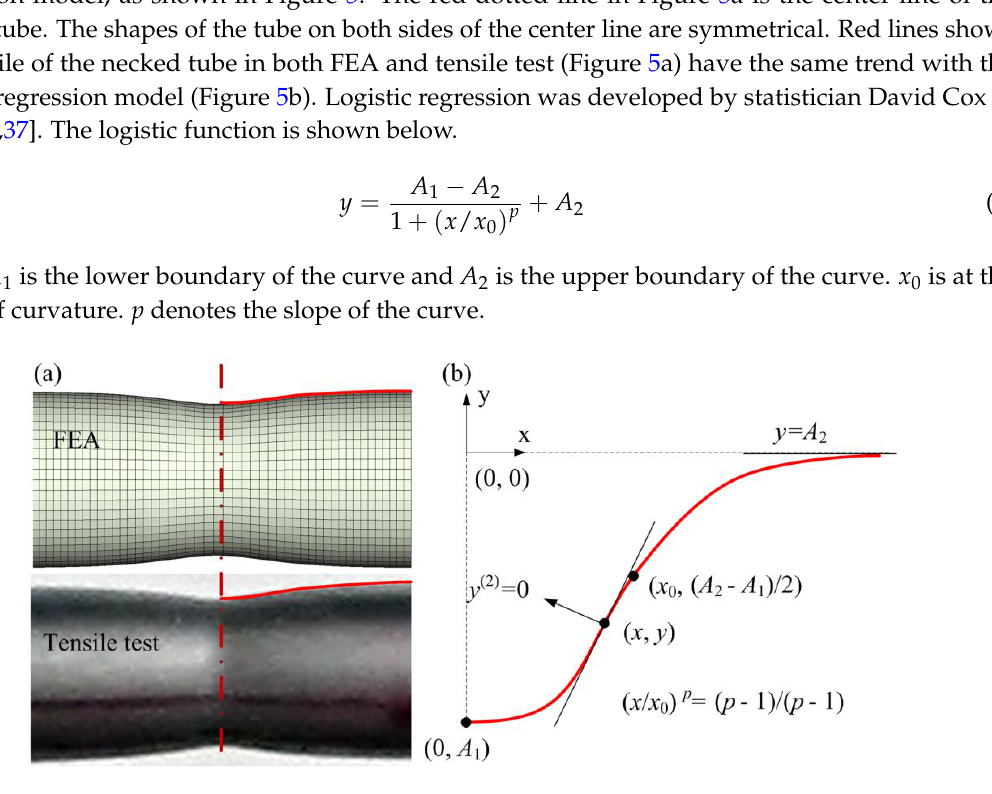
Figure 5. Schematic diagram of logistic regression model: ( a ) a curve that describes the profile of outer wall; ( b ) mathematical model of logistic regression.